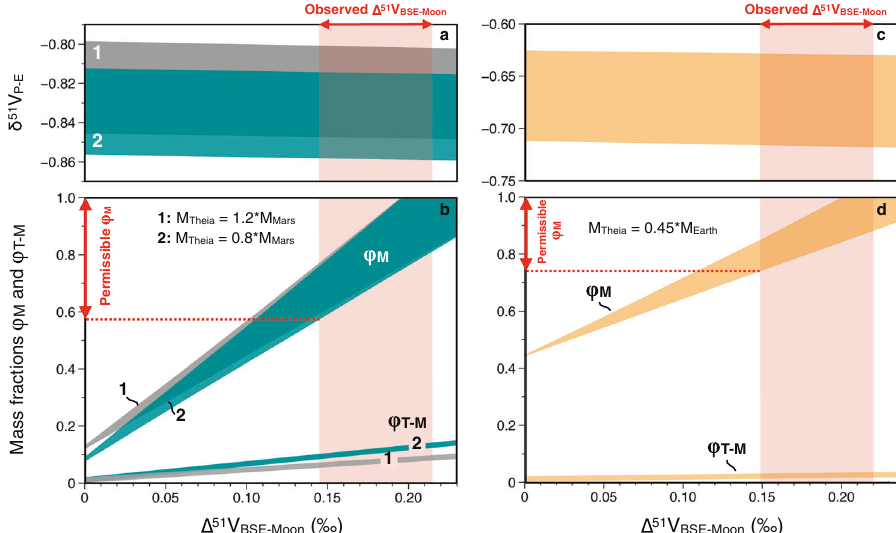
Fig. 3 Isotope mass balance calculation for giant impact scenarios. Results of mass balance calculations for giant impacts where Theia ’ s mass (MTheia) represents 0.8 or 1.2 times that of Mars (MMars) ( a and b ) or 0.45 Earth masses (Mearth) ( c and d ). It is assumed that Theia was chondritic in composition ( δ 51 V = − 1.089 ± 0.031; 2SE) and that the silicate portions of proto-Earth and Theia had identical V concentrations. The mass fractions (i) of the Moon deriving from Theia ( φ M ) and (ii) of Theia that is incorporated into the Moon ( φ T-M = φ M * M Moon / M Theia ), are shown as a function of Δ 51 V BSE- φ E ) is also displayed in ( b and d ). Details of these mass balance Moon (Table 1). The mass fraction of the present-day Earth that originates from Theia ( calculations are reported in the Supplementary Note 3. Given the observed Δ 51 V BSE-Moon = − 0.181 ± 0.035 ‰ (95% c.i.), it can be seen that the minimum fraction of Theia in the Moon is ~60%, with any value up to 100% being allowed. The range of typical φ M values derived from the canonical giant impact model is 72 – 88%. The best estimate for φ M (when Δ 51 V BSE-Moon = − 0.181) ranges from 79% when the impactor is 0.8*M Mars to 87% when the impactor is 0.45*M Earth (Table 1), in excellent agreement with predictions from the canonical giant impact scenario.